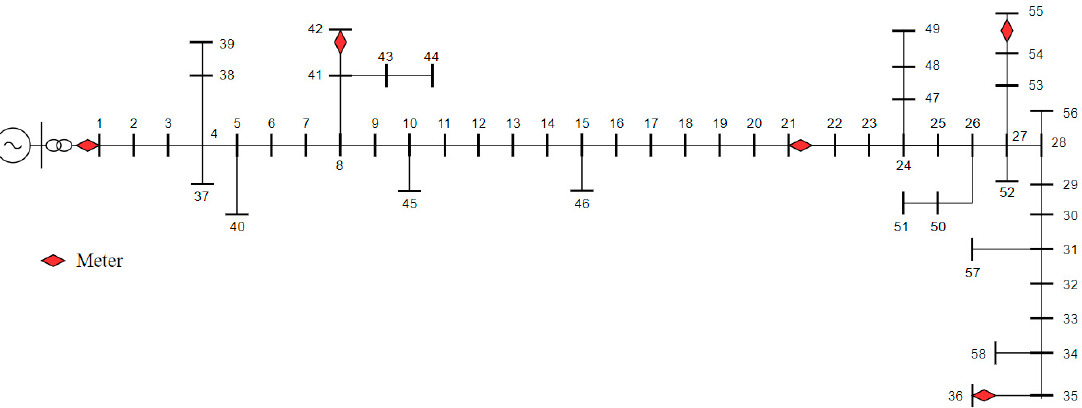
Figure 5. Real urban distribution system (58 nodes).